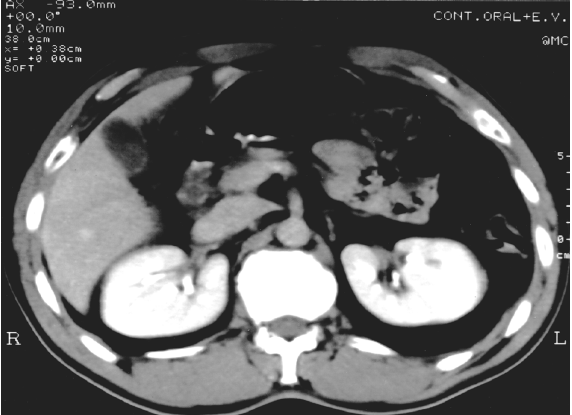
Figure 2 – Abdominal computerized tomography with venous contrast, performed 5 months after thrombolytic therapy, re- vealing total reperfusion of both